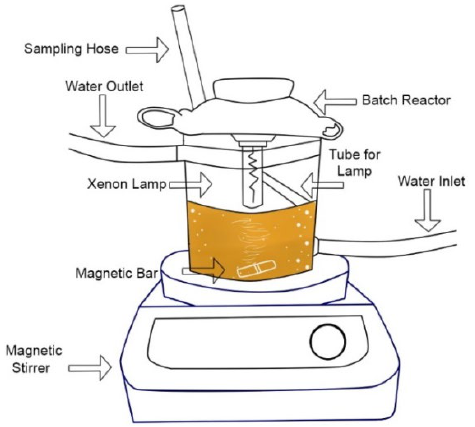
Figure 2. Experimental set-up for the photocatalytic activity assays.